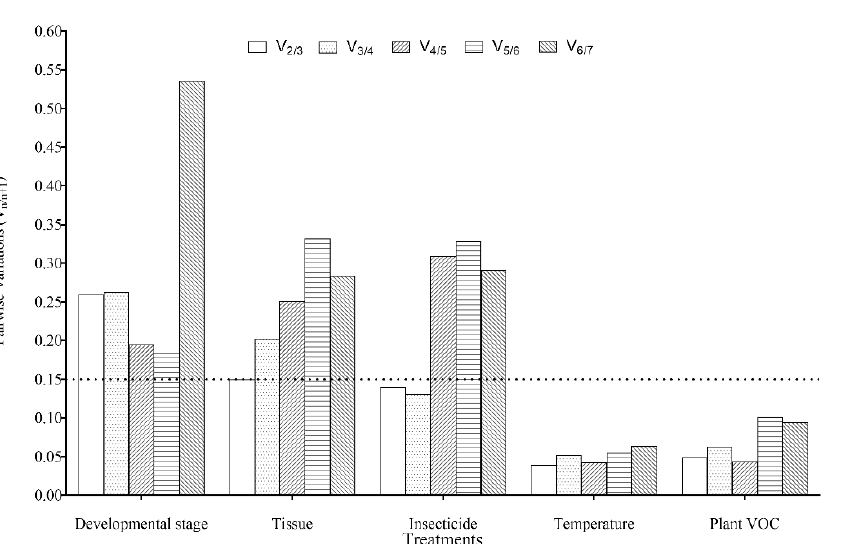
Figure 3. Optimal number of reference genes for normalization in RT-qPCR of T. absoluta under different conditions. The pairwise variation (V n /V n +1, n is the number of reference genes) analyzed using the geNorm software was used to determine the optimal number of reference genes required for accurate normalization. Black dotted lines indicate the threshold for paired variation values (V n /V n +1 = 0.15). V n / n +1 < 0.15 indicates that the optimal number of reference genes for normalization is n , and the V n / n +1 > 0.15 indicates that the optimal number is n +1.